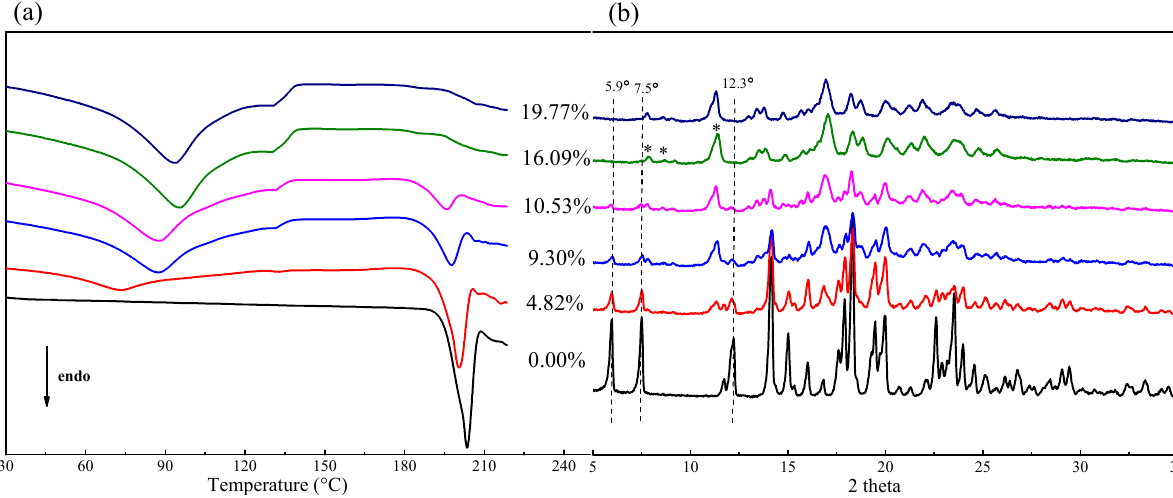
Figure 4. DSC thermogram ( a ) and PXRD patterns ( b ) of FXD–water physical mixtures by wet ‐ granulation process with different water contents. The (*) pointed the appearance of characteristic peaks for Form II with the increase of water content.